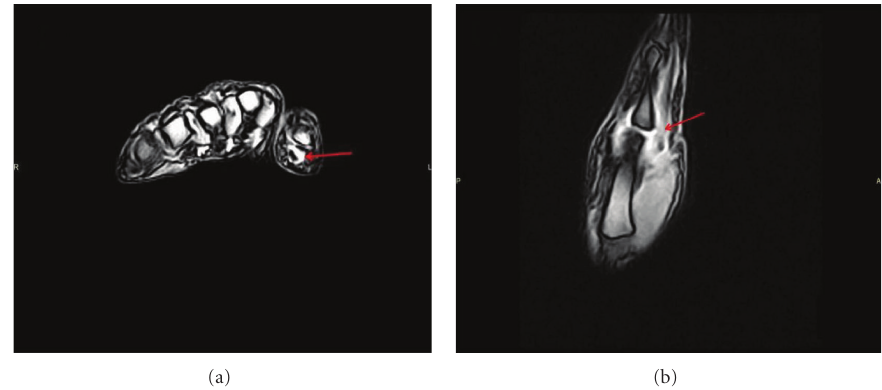
Figure 2: (a) T2 weighted MRI of the left hand shows a fluid distension of the sheath of the flexor tendons of the thumb. (b) T2 weighted MRI of the left hand shows fluid distension of the joint capsule of the 1st